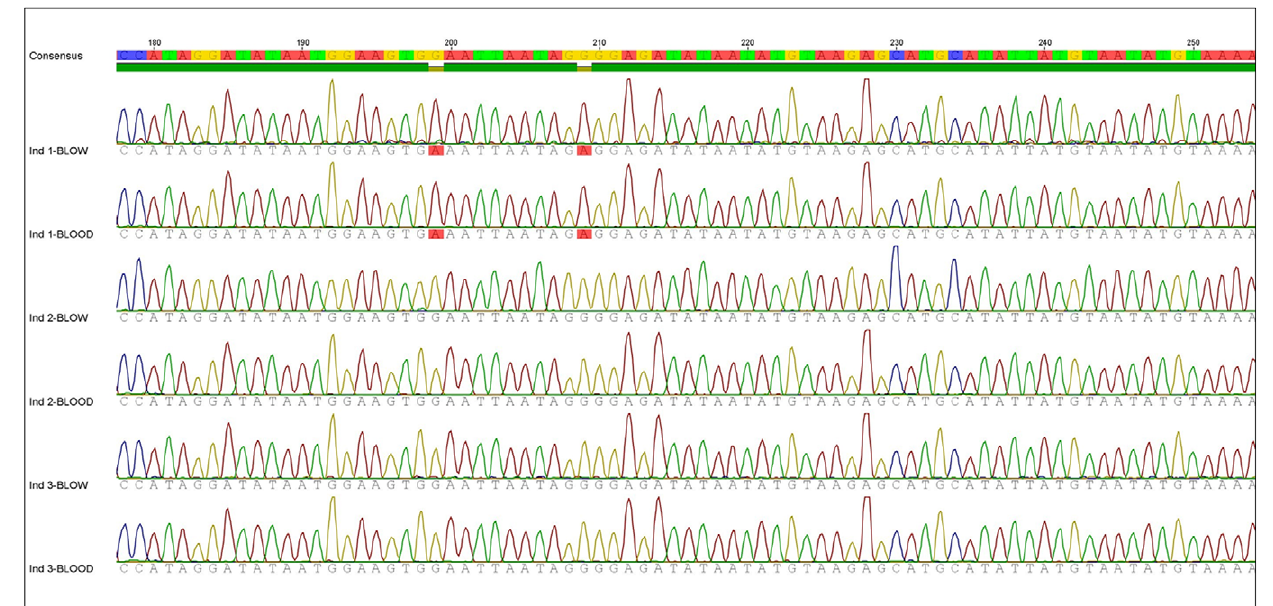
Figure 3. Mitochondrial DNA profile of blow and blood from individuals 1 to 3. To estimate whether the mitochondrial DNA profile collected from an individual’s blow matched the mitochondrial DNA profile collected from its blood, we amplified a 426 base-pair fragment of the maternally inherited mitochondrial DNA control region using the primers dlp1.5 [25] and dlp5 [26]. The PCR products were cleaned using ExoSAP-IT from Affymetrix. Cycle sequencing was conducted with the BigDyeTM Terminator Cycle Sequencing Ready Reaction kit (Applied Biosystems). After a magnesium sulphate (MgSO4) clean-up, the sequencing fragments were run on an ABI 3730 DNA Sequencer (Applied Biosystems). The sequences were visualised and edited using Geneious Pro version 5.0. Out of the 434 base-pair fragments amplified across the seven individuals, we identified only two polymorphic sites. As a result and for ease of presentation, we only include here a figure showing an 80 base-pair fragment including the two polymorphic sites for three of the six individuals (178 bp-255 bp). The remaining three individuals’ mtDNA profile is available in the supporting online information Figure S2. The full sequences for all six individuals have been made available on GenBank